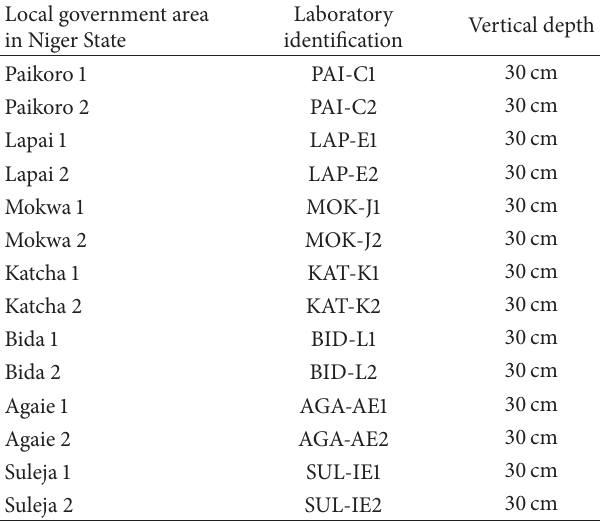
Table 2: Sampling sites with horizontal